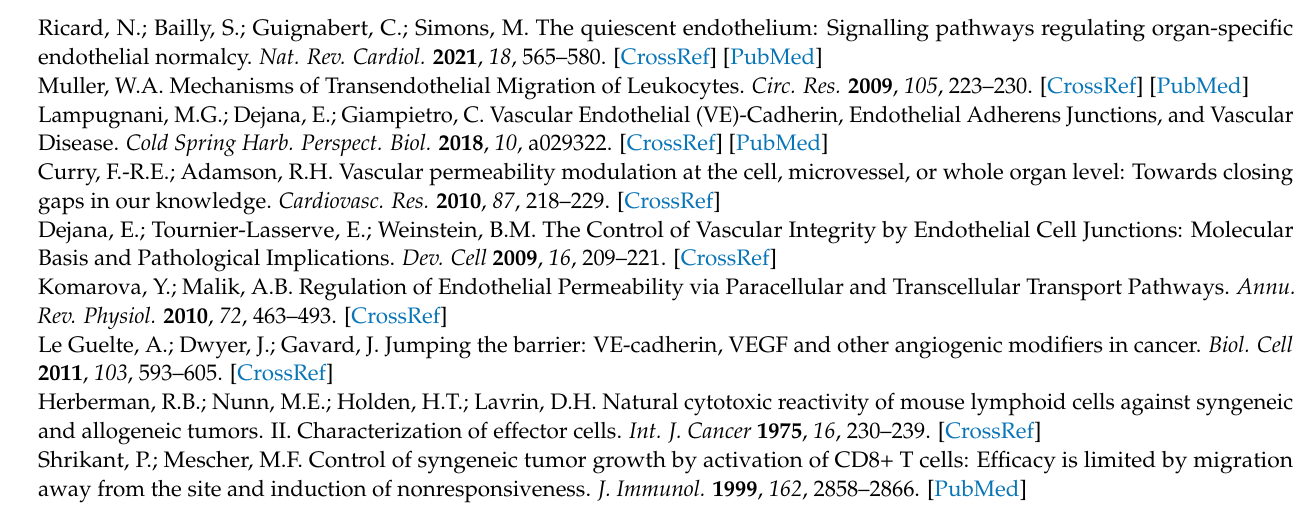
procedure, Figure S3: Double VFP making of blood vessels, Table S1: Dimensions of the VoC lumens using double VFP, Video S1: Endothelial cell suspension carving through the collagen solution by VFP, Video S2: Detailed VFP